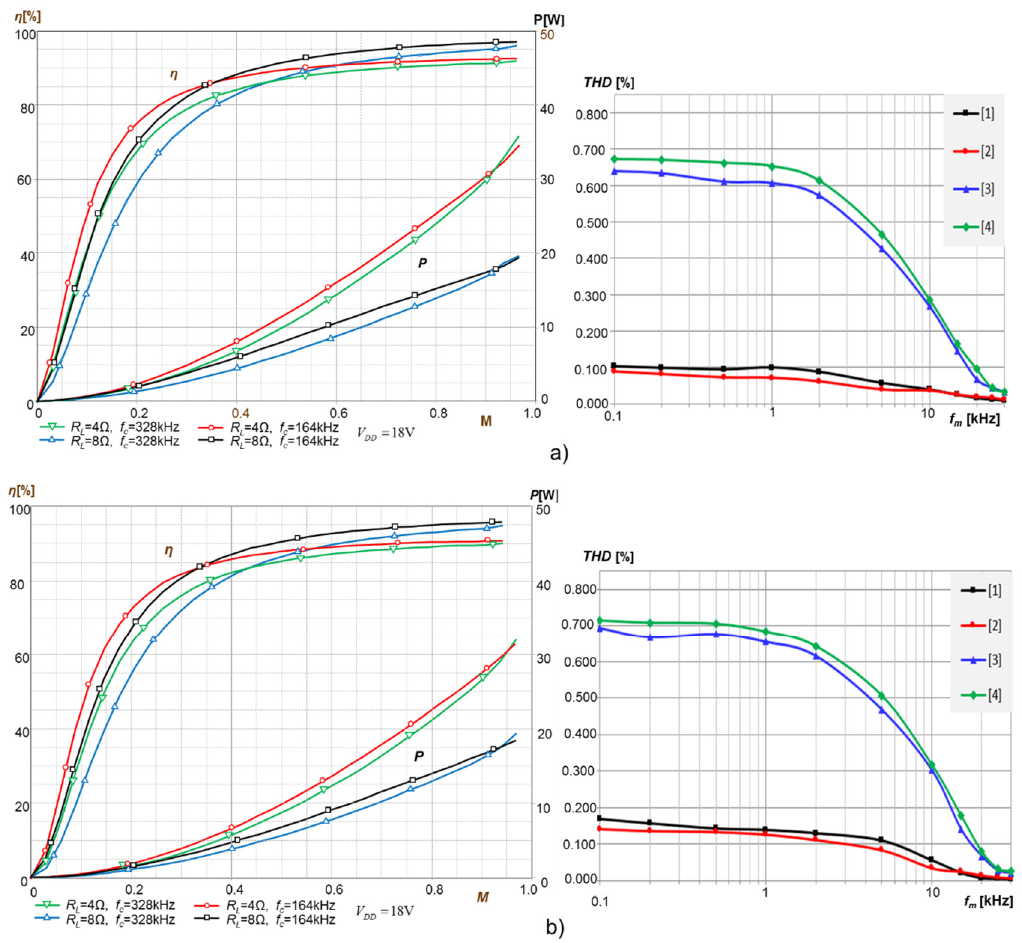
Figure 9. The output power and efficiency versus modulation index M (on the left) and THD versus the f m frequency of the modulating signal (on the right): ( a ) conventional Class-BD amplifier (Figure 3); ( b ) Class-BD amplifier with a balanced CM output (Figure 5).